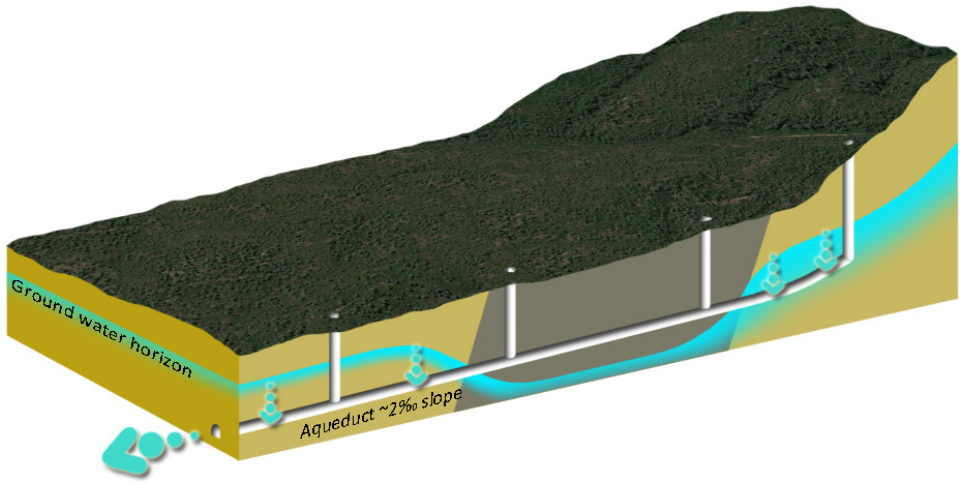
Figure 12. The function of the aqueduct.